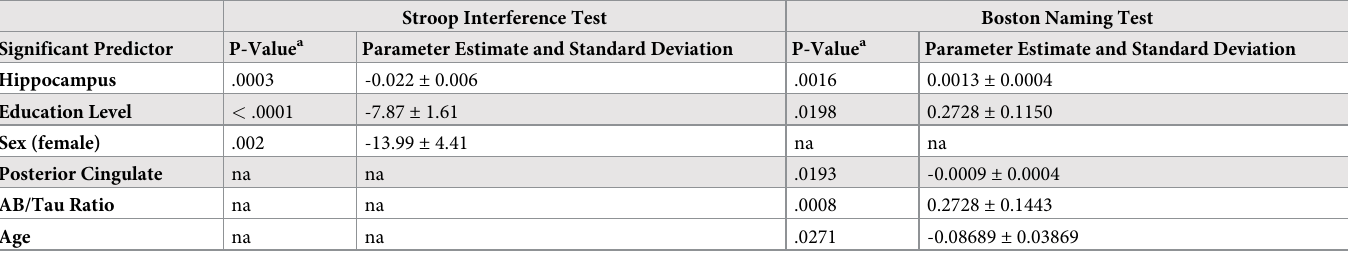
Table 2. Stepwise best fit model reveals best predictors of Stroop interference and Boston naming test raw scores taking into account regional brain volume, CSF protein levels, education level, age, and